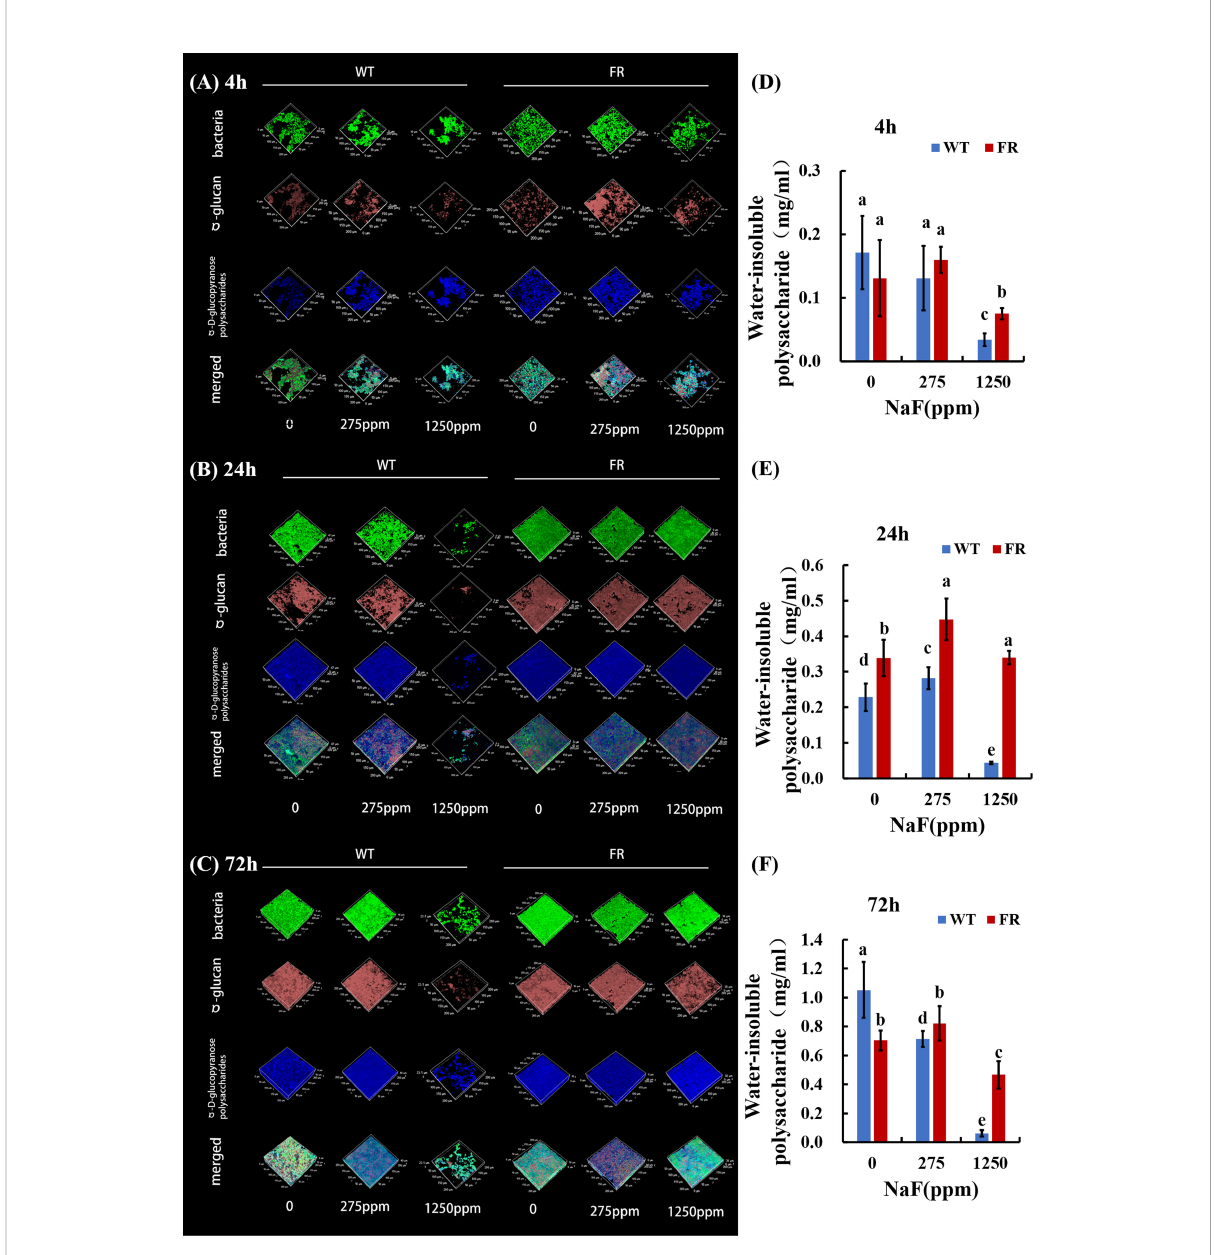
FIGURE 1 Polysaccharide analysis of bio fi lms. (A-C) Bacterial and polysaccharide staining of bio fi lms. Bacteria were labeled with green, dextran was stained red, and a -polysaccharides were dyed blue. (D-F) Water-insoluble polysaccharide of bio fi lms revealed by anthrone mensuration. Data are presented as mean ± standard deviation, and different letters demonstrate a signi fi cant difference between groups (P <